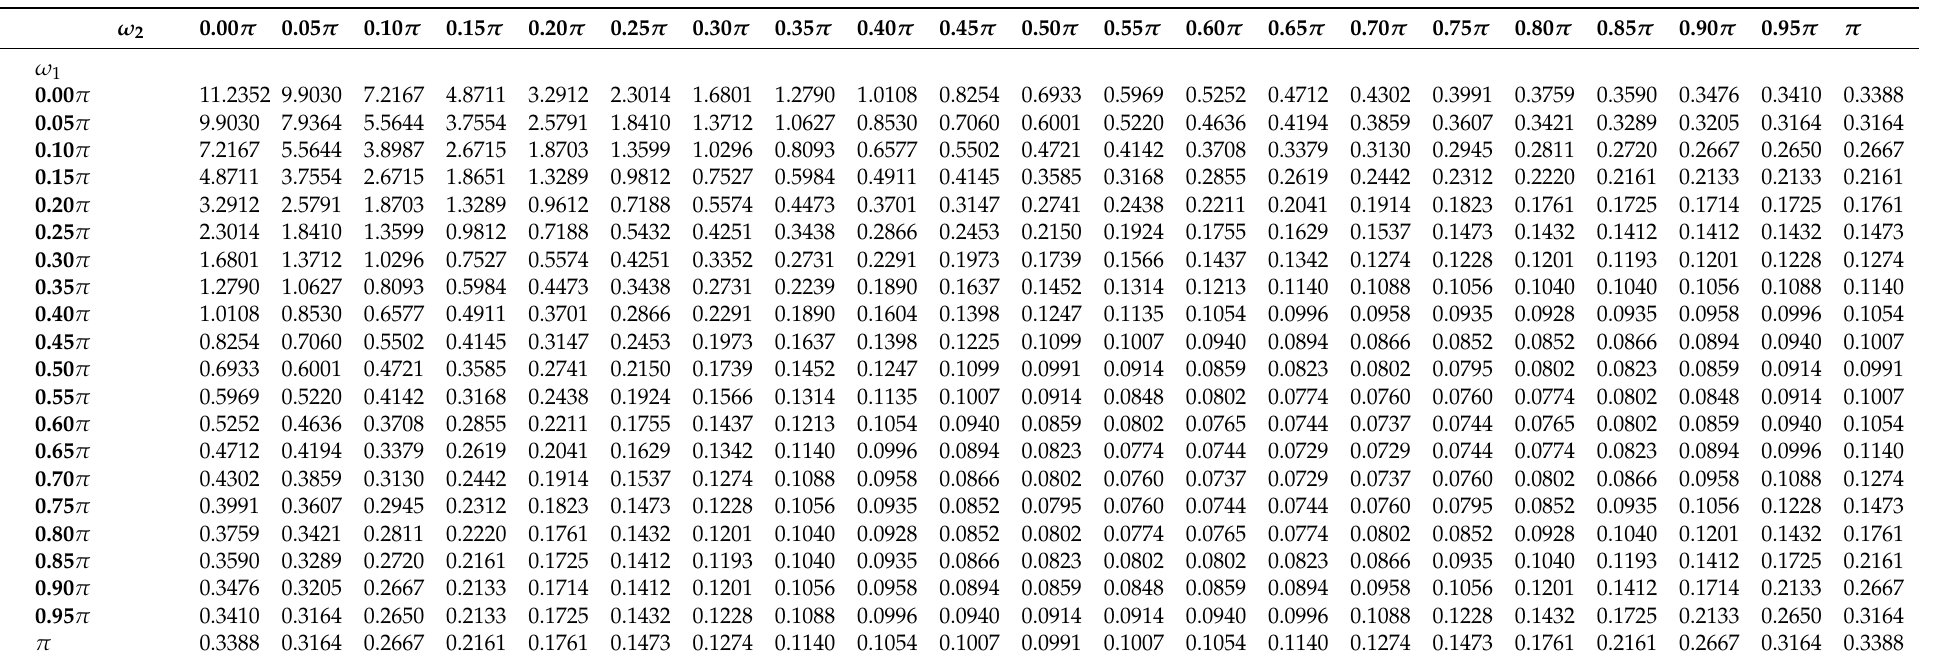
Table 1. Numerical values of theoretical bispectrum modulus of DCGINAR(1) with α = 0.6, θ = 0.7 and µ =